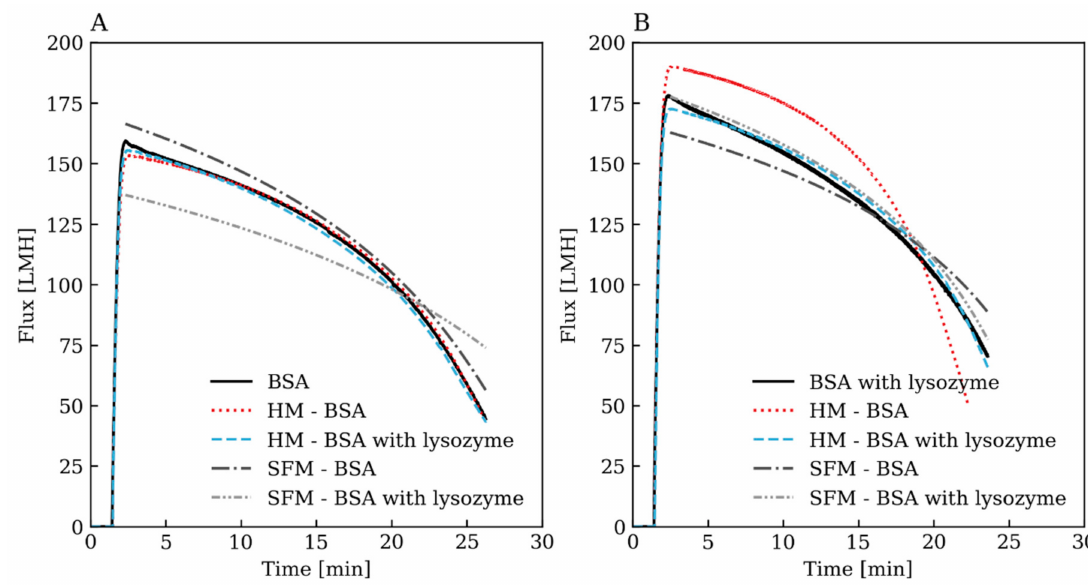
Figure 4. Comparing flux prediction of the test set containing ( A ) BSA (TMP 1.8 bar, CF 200 mL / min, initial c B,BSA 6.68 g / L) and ( B ) BSA with lysozyme (TMP 2.1 bar, CF 250 mL / min, initial c B,BSA 3.71 g / L, initial c B,Lys 0.38 g / L), with: hybrid model HM 1 trained on BSA solely (red dotted line) and the BSA and two-component training set (blue dashed line); SFM based on BSA solely (dark grey dot-dashed line) and two-component training set (light grey dot-dot-dashed